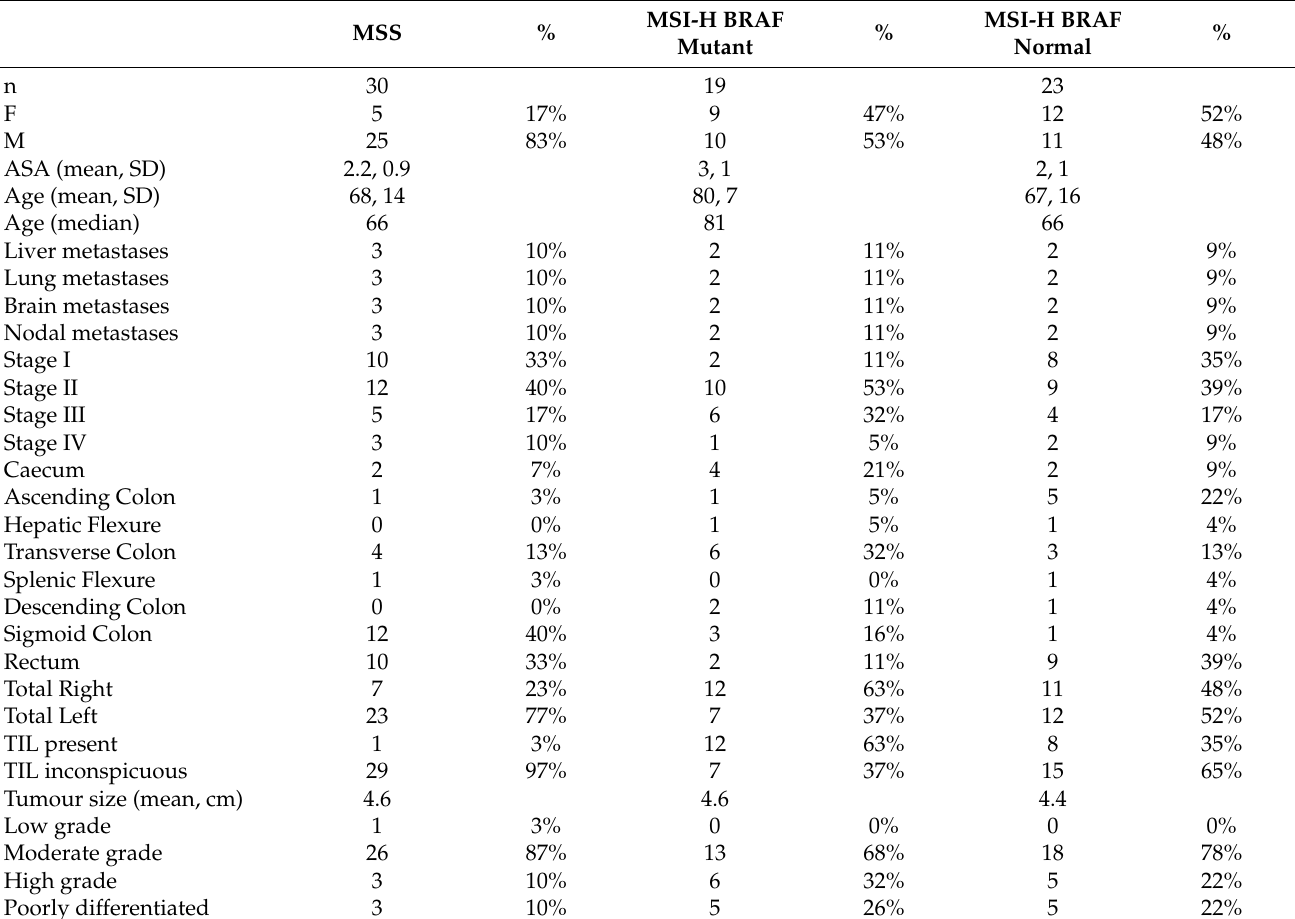
Table 1. Patient and tumour characteristics based on MSI and BRAF